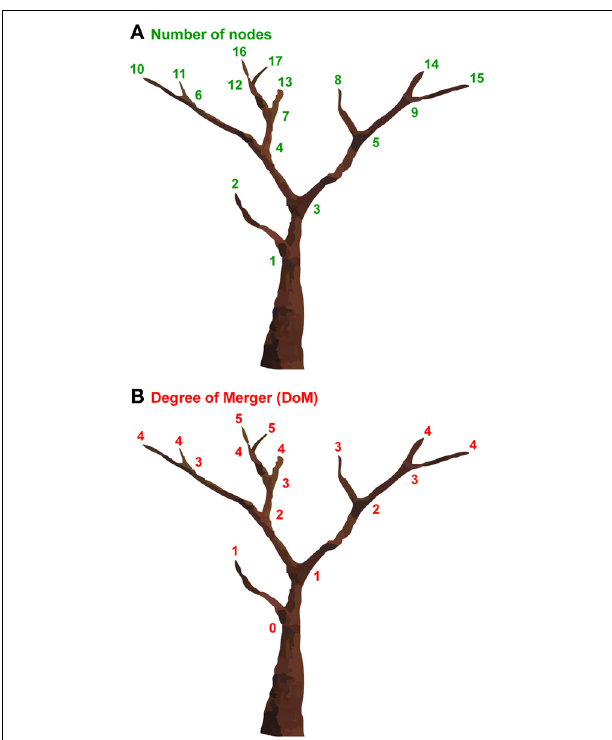
FIGURE 1 | Two models for measuring the complexity of tree structures. (A) “The number of nodes” counts the total number of nonterminal nodes (branching points) and terminal nodes of a tree structure. The number of nodes of the tree structure shown is 17. (B) “The Degree of Merger (DoM)” quantifies the maximum depth of merged subtrees, or the degree of branching. We increased the number one by one for each node, starting from the trunk (zero) to terminal nodes. The DoM of the tree structure shown is 5.